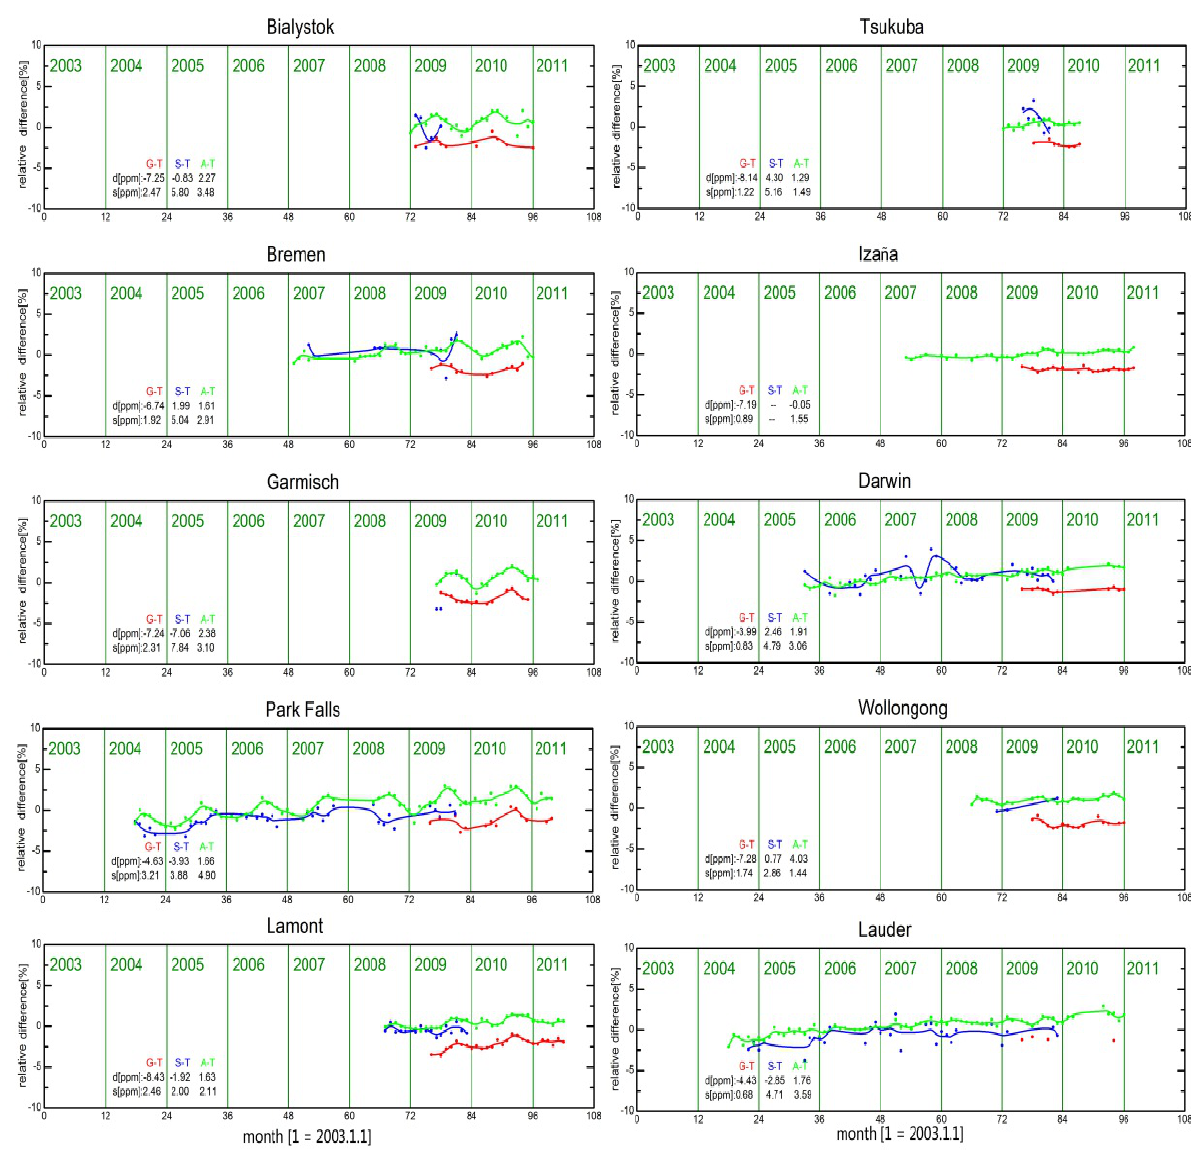
Figure 4. Percent differences between g-b FTS and the satellite products, GOSAT (red), SCIAMACHY (blue) and AIRS (green), at selected TCCON sites for the years 2003–2011. The solid lines have been smoothed using a five-month Hann window. The following numbers have been computed based on the monthly averages: n is the number of comparison pairs; d is the absolute mean difference (in ppm); and s denotes the standard deviation of the difference (in ppm). The complete results are summarized in Table